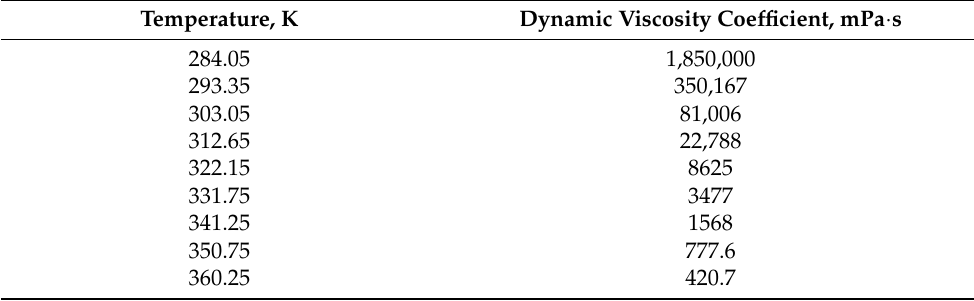
Table 5. Temperature-dependent Cold Lake bitumen oil dynamic viscosity